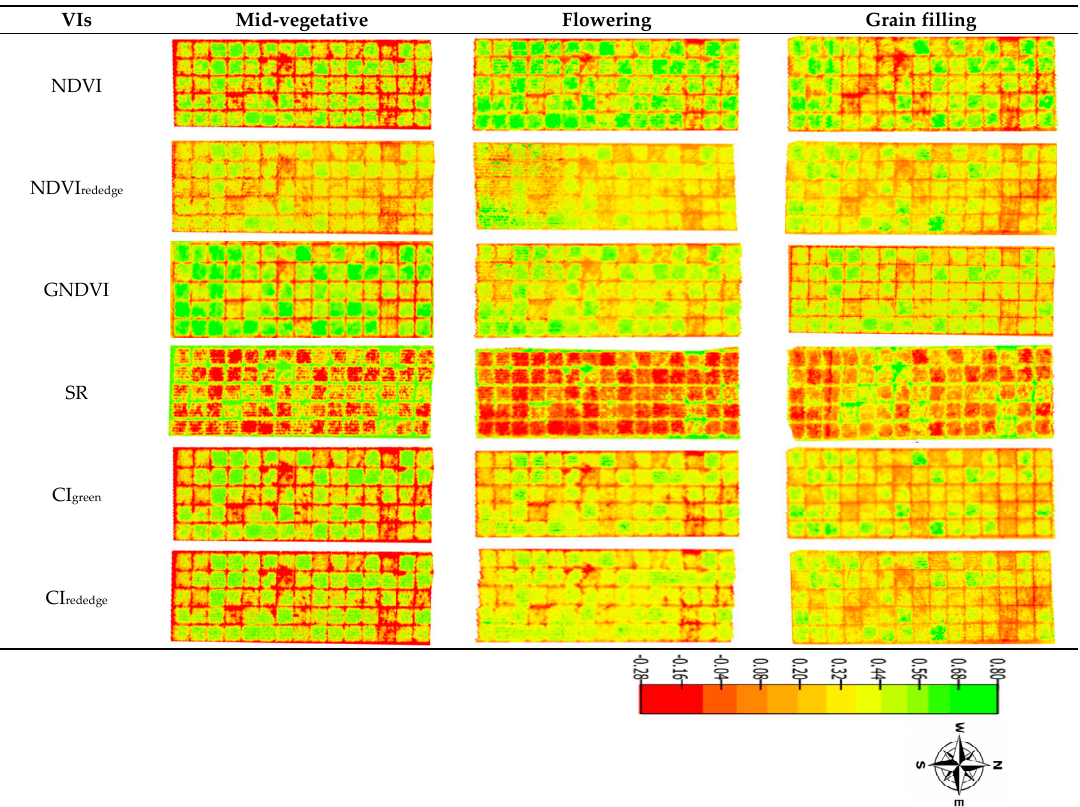
Figure 4. UAV-based multispectral images at different phenological plant stages. VIs = Vegetation Indices; NDVI = Normalized Difference Vegetation Index; GNDVI = Green Normalized Difference Vegetation Index; NDVI rededge = Rededge Normalized Difference Vegetation Index; SR = Simple Ratio, CI green = Green Chlorophyll Index; CI rededge = Rededge Chlorophyll Index.